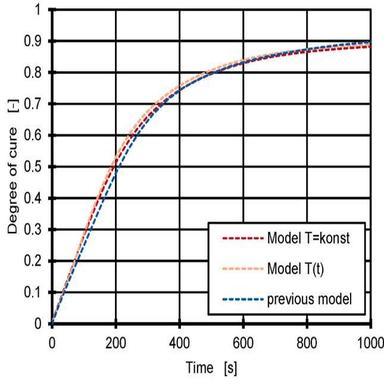
ξ(t) according to eqs.–(8) for isothermal cure at 100 ◦C, consideration of the temperature profile T(t) during the improved RPCSA measurements and previous model .